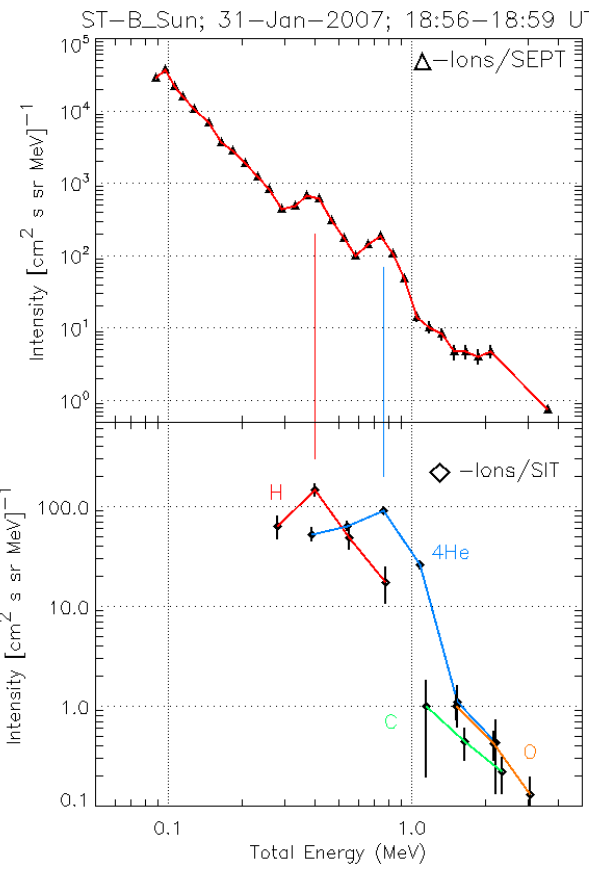
Fig. 4. AMI event observed simultaneously with the SEPT (top panel) and SIT (bottom panel) instruments onboard STEREO-B on 31 January 2007. Both spectra show two peaks around 370 and 740 keV with the peak energy ratio of 1:2.